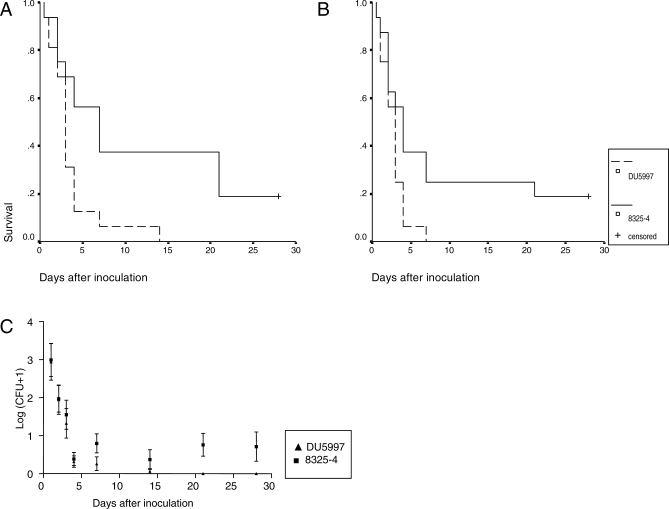
Survival in the Nose of the Wild-Type Strain versus the Mutant Strain(A) Kaplan-Meier survival curve of the 8325–4 S. aureus (solid line) and its ClfB− mutant (DU5997) strain (dashed line) in human nose (last cultured strain in either nostril). All cells of the mutant strain were eliminated after a period of 14 d, which is significantly faster than the elimination rate for the 8325–4 S. aureus strain.(B) Kaplan-Meier survival curve of the 8325–4 S. aureus (WT) and ClfB− mutant (DU5997; dashed line) that were inoculated together as a mix in one nostril.(C) Number of cfu of 8325–4 and DU5997 in follow-up samples.